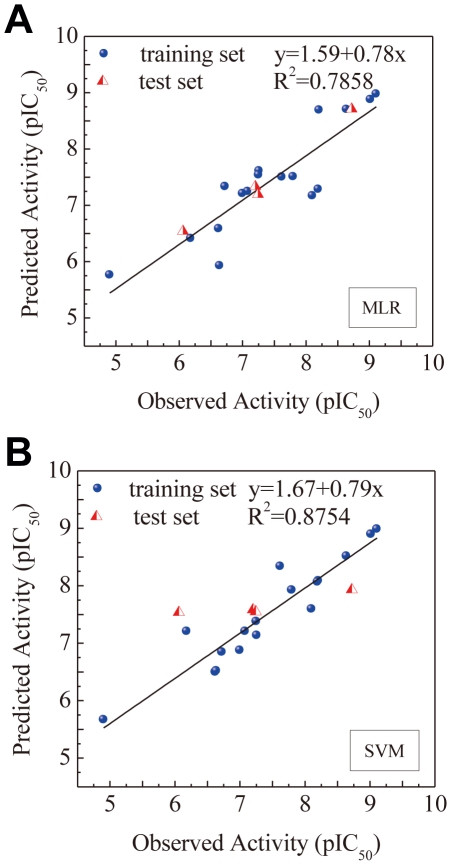
Correlation of observed and predicted activity (pIC50) using 2D-QSAR models.(A) MLR and (B) SVM.